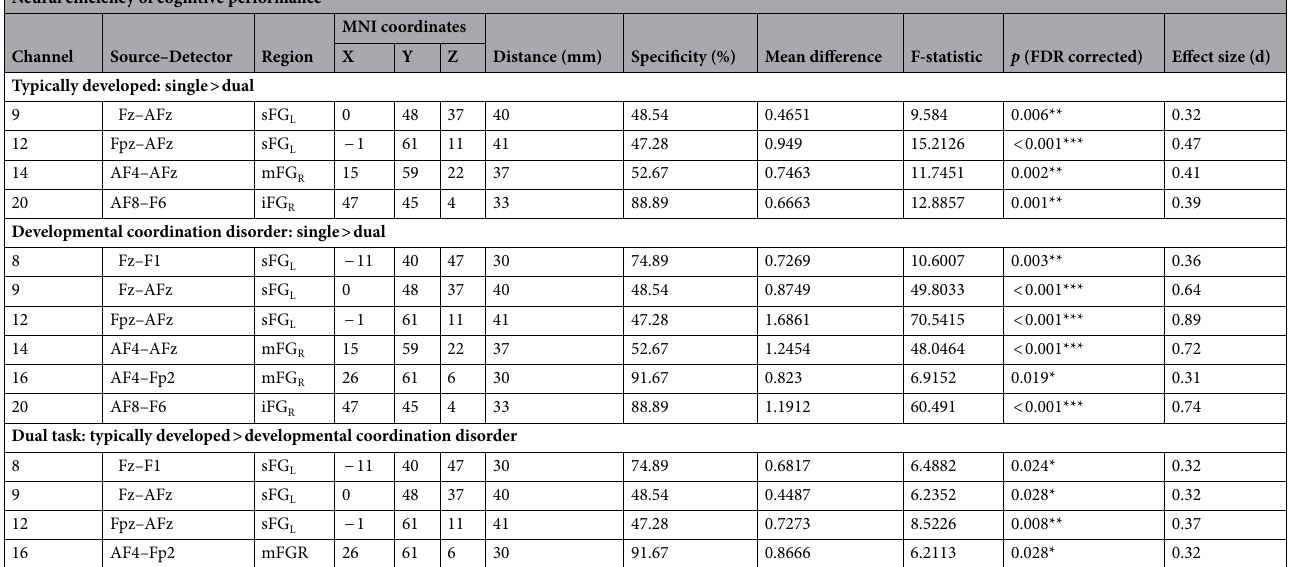
Table 2. Neural efficiency (interaction effects of group and tasks). Significant Channels (at Source–Detector locations) using MNI coordinates (X, Y, and Z), with the region designation of Neural Efficiency of Cognitive Performance for the Interaction Effect of Group and Task between Typically Developed (TD) and Developmental Coordination Disorder (DCD) children and tasks (Single and Dual). Specificity/Coverage of the region is depicted, with the mean difference for the comparison, along with statistical information (F-statistic, p -value, and effect size). ( p < 0.05*, p < 0.01**, p < 0.001***). No significant channels were implicated during Single Task, comparing TD and DCD children, nor for the interaction effects of NE of PhysP.